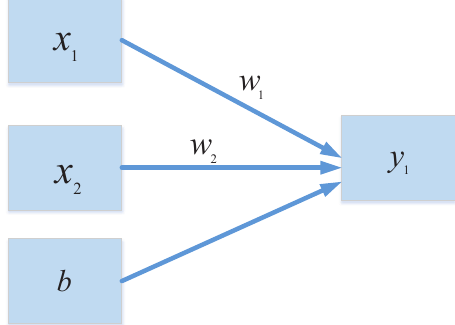
Figure 2. A single layer perceptron without activation